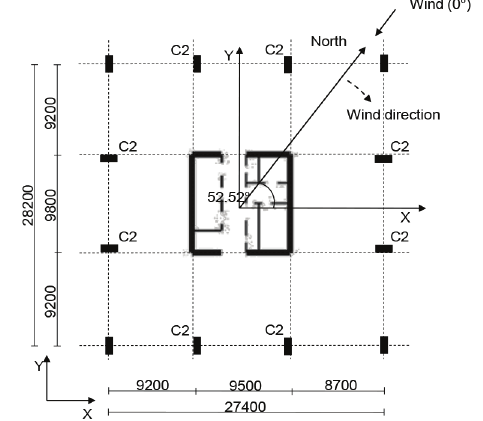
Fig. 4. Plan view of the 37-storey